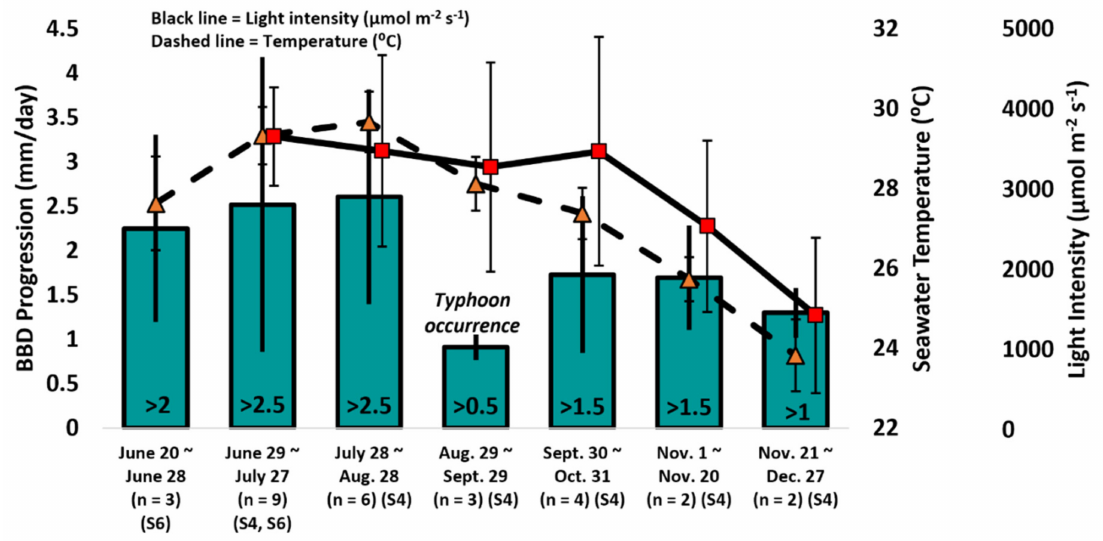
Figure 8. Bars represent mean BBD progression rates on encrusting Montipora colonies from June to December 2020 with associated seawater temperatures (black dashed line and triangle markers). (Spearman’s r (57) = 0.3, p = 0.02) and light intensity (black line with red square markers). Typhoons Maysak and Haishen occurred in September 2020. Seawater temperatures were obtained from loggers at sites S4 and S11. Light intensities were calculated by obtaining maximum light for each day and then calculating their monthly averages. Numbers inside the bar represent the mean BBD progression greater than the mentioned value (Supplementary file Figure